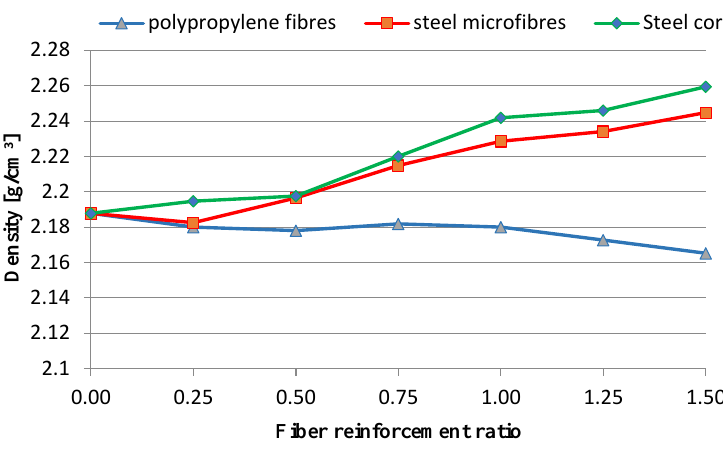
Figure 6. Density of tested mixtures.